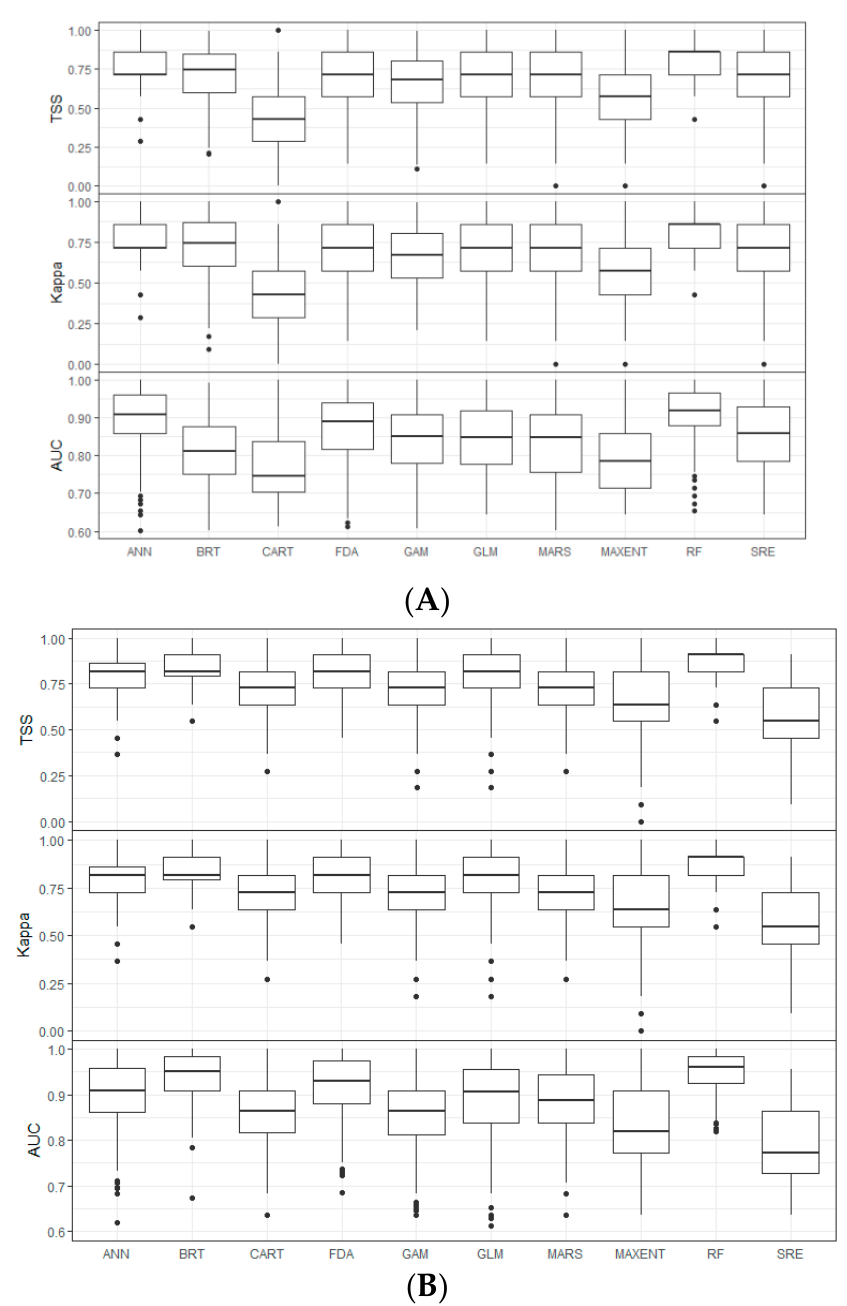
Figure 3. S Plot of model performance (AUC, Kappa, TSS) for 100 repetitions of each technique on Uruguay including Artificial Neural Networks (ANN), Boosted Regression Trees (GBM), Classification and Regression Trees (CTA), Flexible Discriminant Analysis (FDA), Generalize Additive Models (GAM), Generalized Lineal Models (GLM), Multivariate Adaptive Regression Splines (MARS), Maximum Entropy (MaxEnt), Random Forests (RF) and Surface Range Envelop (SRE) for Eucalyptus dunnii ( A ) and E. grandis ( B ) in Uruguay.